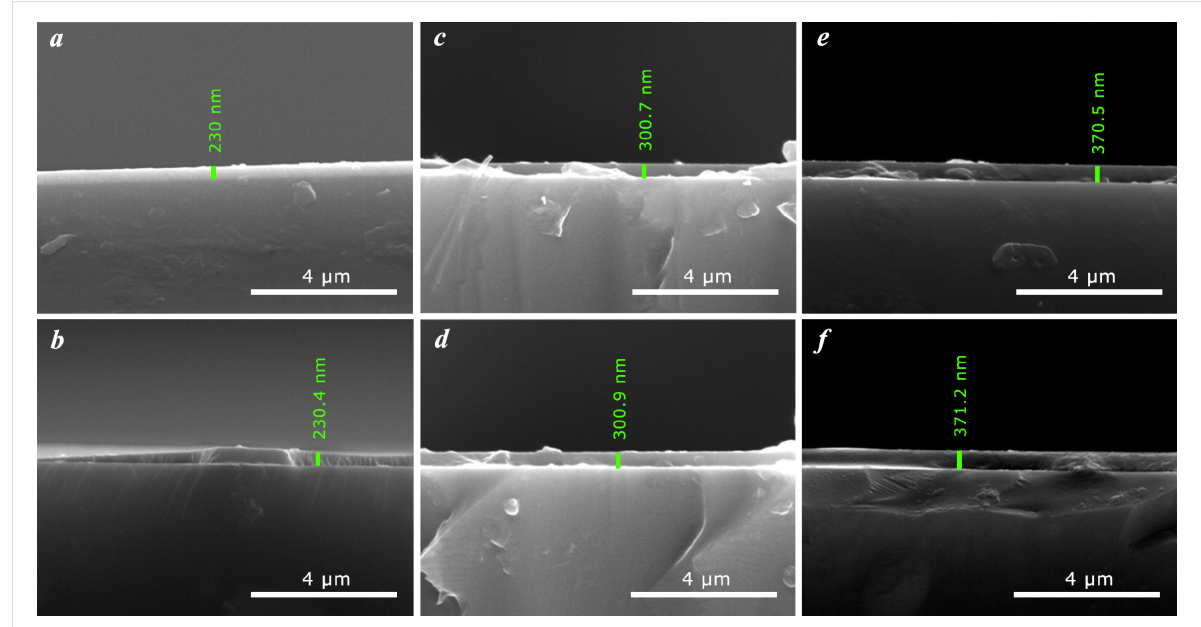
Figure 1: Cross-sectional SEM images of the cleaved as-deposited (a,c,e) and RTA-processed (b,d,f) ITO films, with measured thickness values of: a) d ITO230 = 230 nm, b) d ITO230 = 230.4 nm; c) d ITO300 = 300.7 nm, d) d ITO300 = 300.9 nm, e) d ITO370 = 370.5 nm, and f) d ITO370 = 371.2